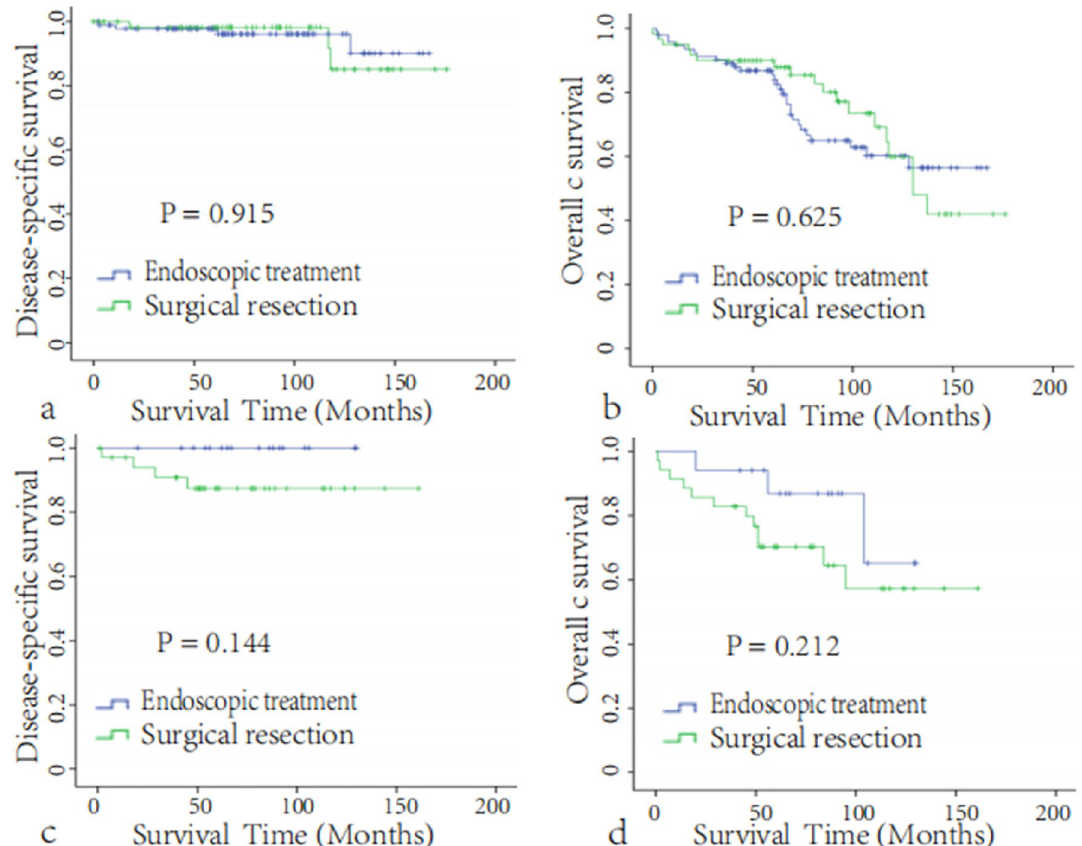
Figure 4. Disease-specific survival ( a ) and overall survival ( b ) of the endoscopic treatment group and surgical resection group for the tumor limiting to the mucosa or submucosa (n = 153). Disease-specific survival ( c ) and overall survival ( d ) of the endoscopic treatment group and surgical resection group for the tumorinvading into the muscularis propria (n =